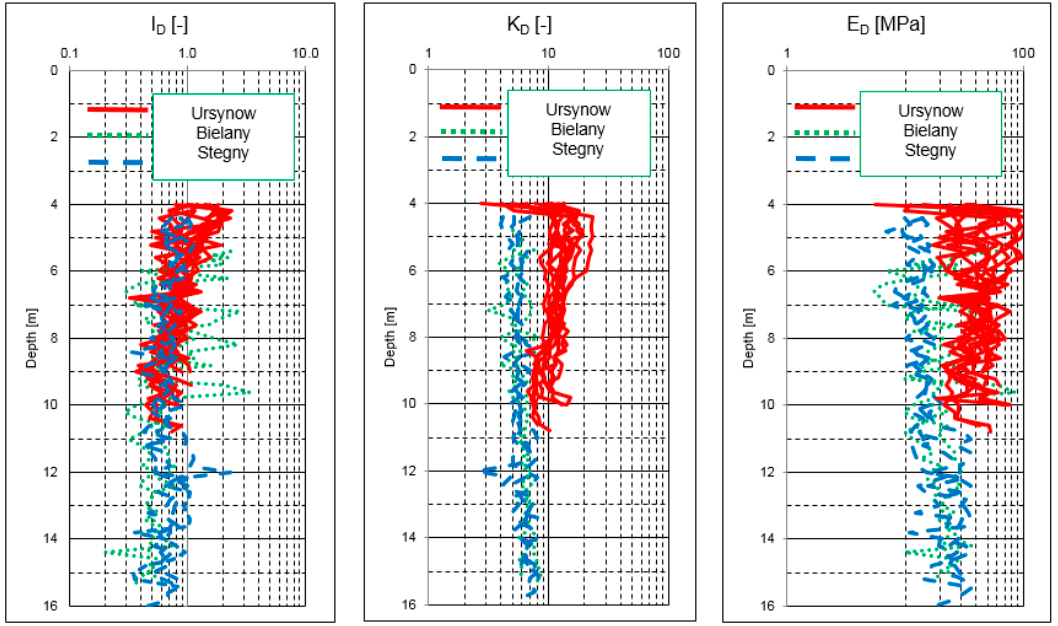
Figure 6. Profiles of the index parameters I D , K D , and E D from seismic dilatometer tests obtained at the Ursynów, Bielany, and Stegny sites. Table 3. Mean value, standard deviation, and coefficient of variation of: The corrected first pressure reading p o or the corrected second pressure reading p 1 , shear wave velocity V s , material index I D , horizontal stress index K D , and dilatometer modulus E D .